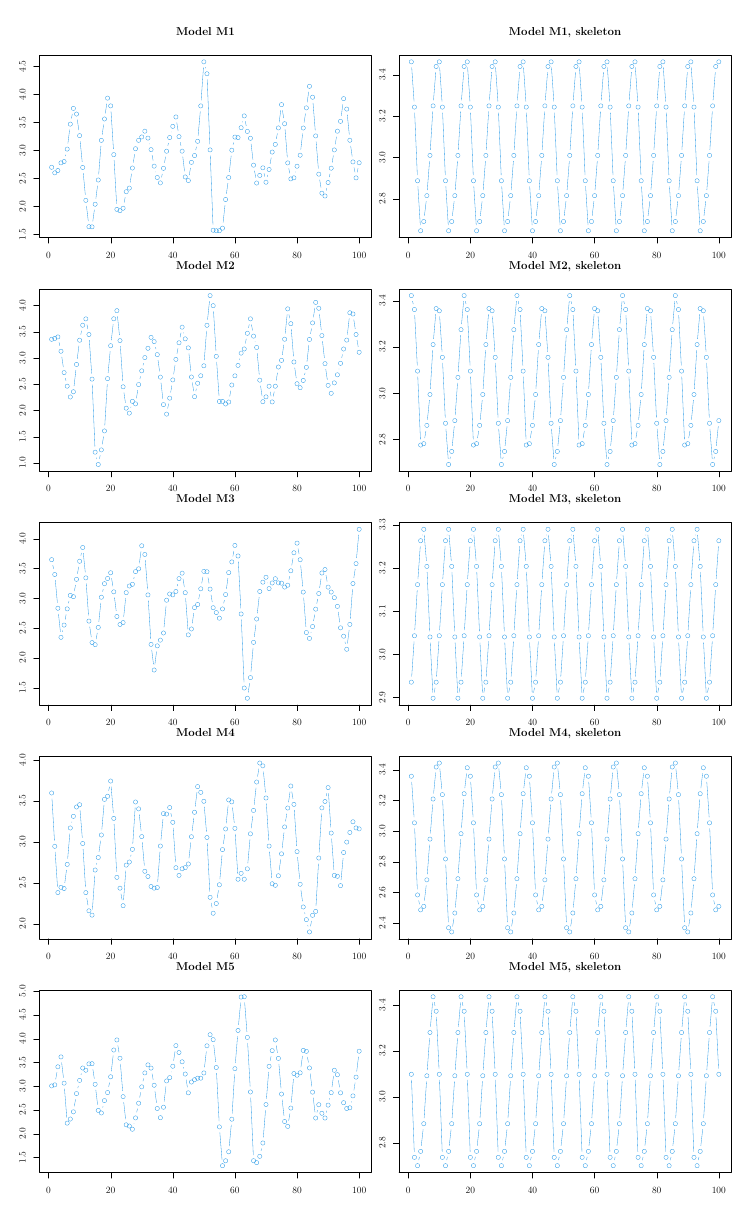
Figure 18 – Time plot of the simulated time series and their skeletons for TAR models M1 –